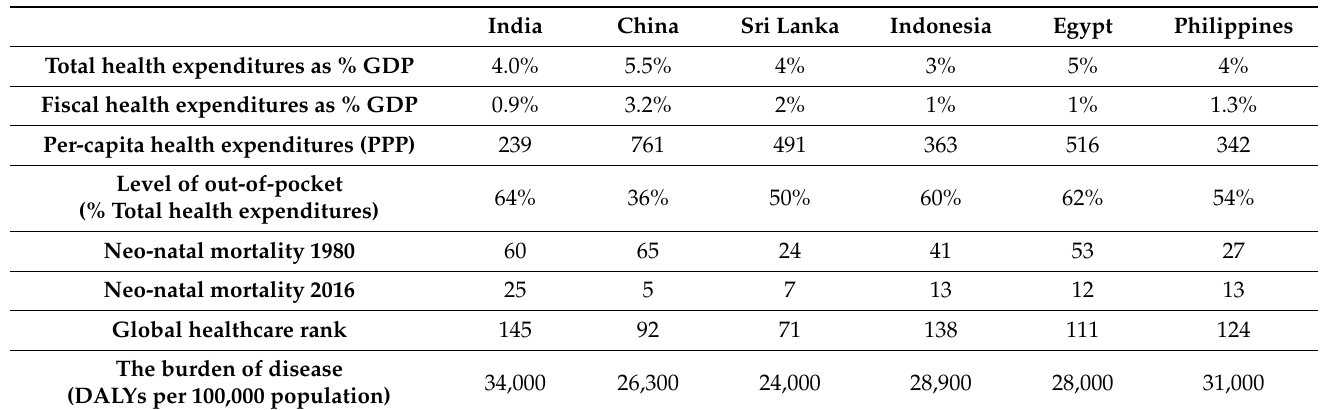
Table 2. Key performance indicators and source: Lancet